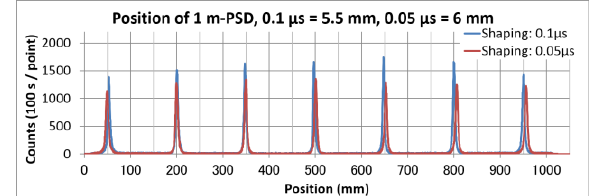
Fig. 11. Position